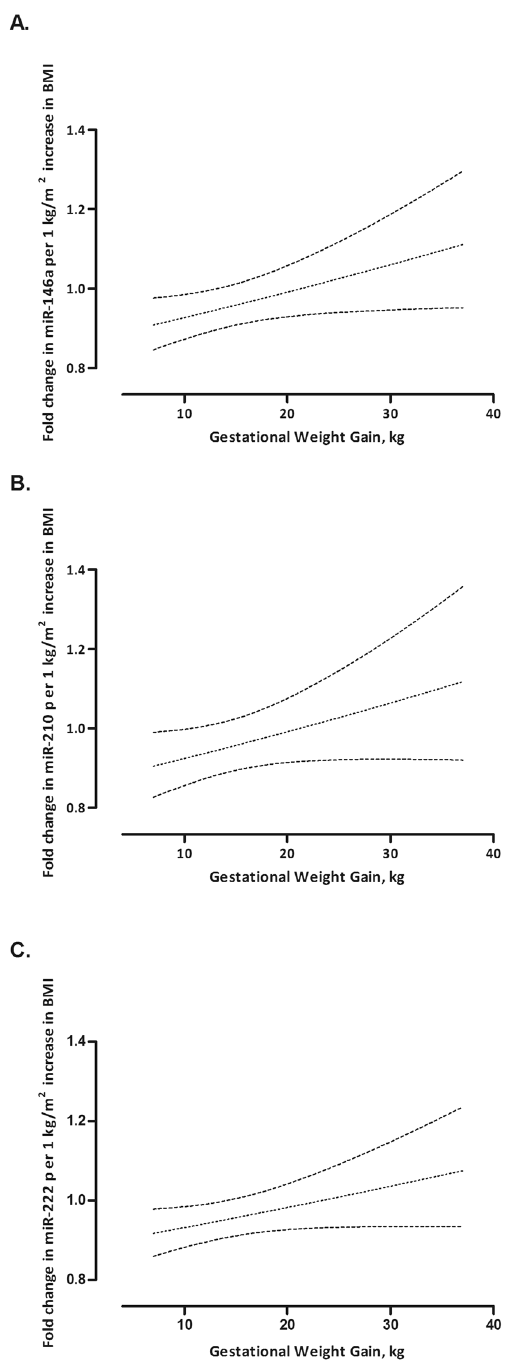
Figure 1. Effect modification by gestational weight gain on the association between maternal pre-pregnancy BMI and placental expression of miR-146a (panel A), miR-210 (panel B) and miR-222 (panel C) in newborn